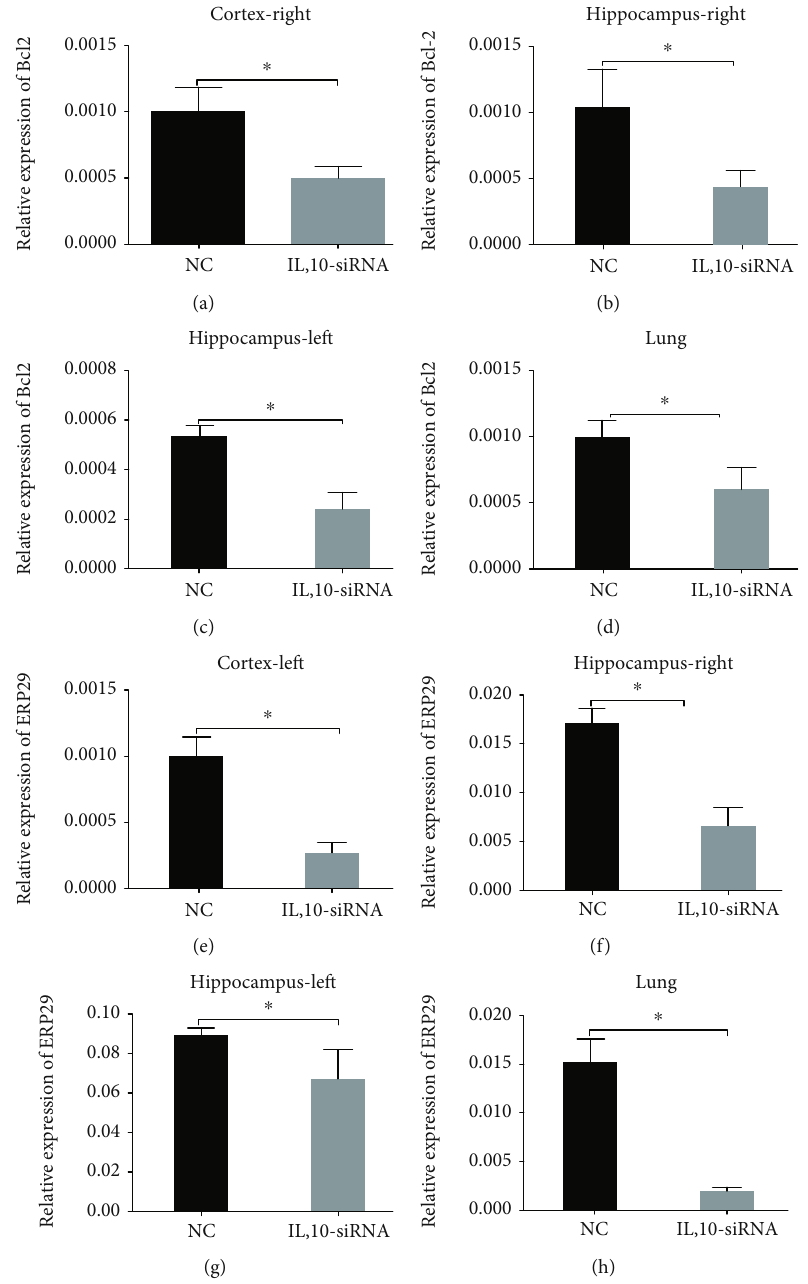
Figure 5: The expression of Bcl-2 and ERp29 in the di ff erent tissues after IL-10 interference. (a)-(d) The quantitative histograms of the relative expression of Bcl-2 in the right cortex, bilateral hippocampus, and lung tissues between NC and IL-10-siRNA groups. (e) – (h) The expression level of ERp29 in the left cortex, bilateral hippocampus, and lung tissues in the NC and IL-10-siRNA groups. NC: negative control group; IL-10-siRNA: silencing RNA of IL-10. Data are presented as mean ± SD , n = 6 /group, ∗ P < 0 : 05